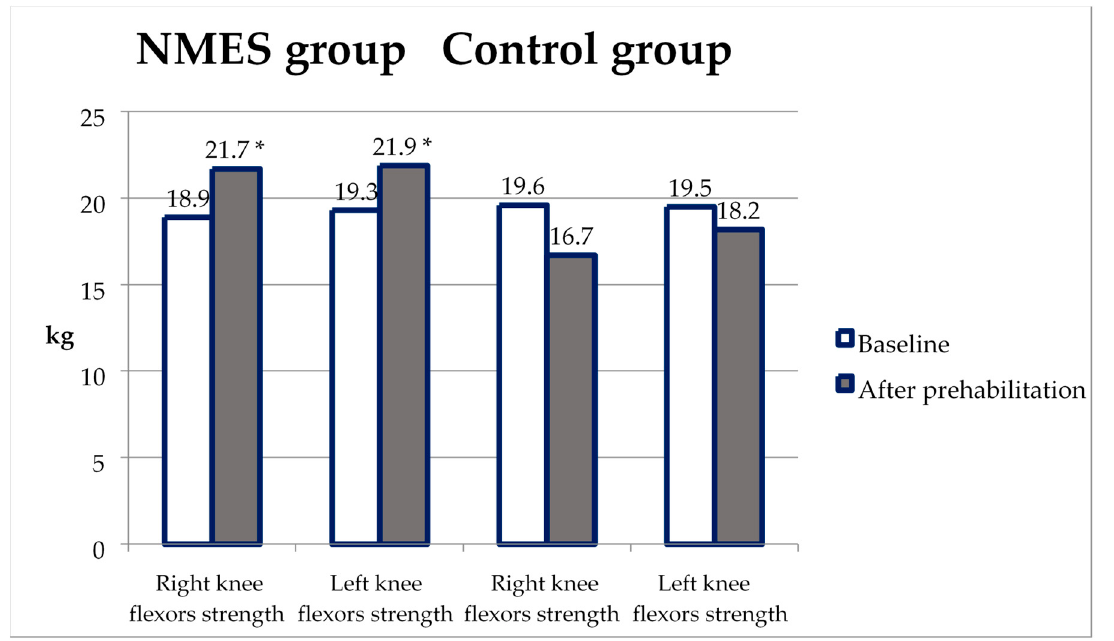
Figure 3. Changes in knee flexor strength from baseline to the second test in the NMES group and control. *— p < 0.05 compared with the control.